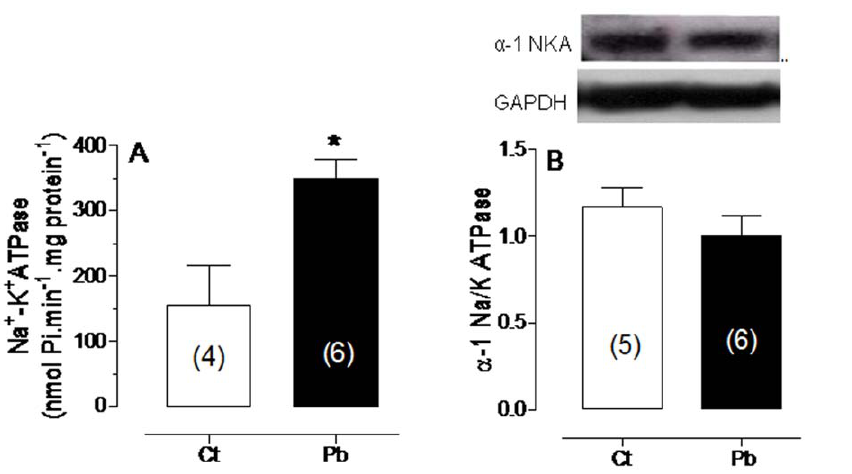
Figure 4. Effects of lead on protein expression and Na + , K + -ATPase activity. Effects of lead exposure on (A) Na + , K + - ATPase activity and (B) the protein expression of the a 1 subunit of Na + , K + - ATPase. *p , 0.05 compared with untreated controls. The number of animals used is indicated in parentheses.